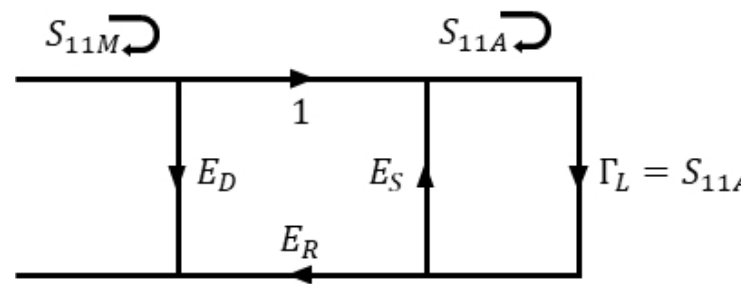
Figure 1. Signal flow graph of the 1-port measurement